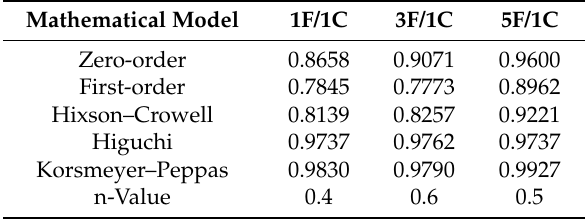
Table 3. Values of R 2 obtained from fits of different mathematical models of mechanisms of